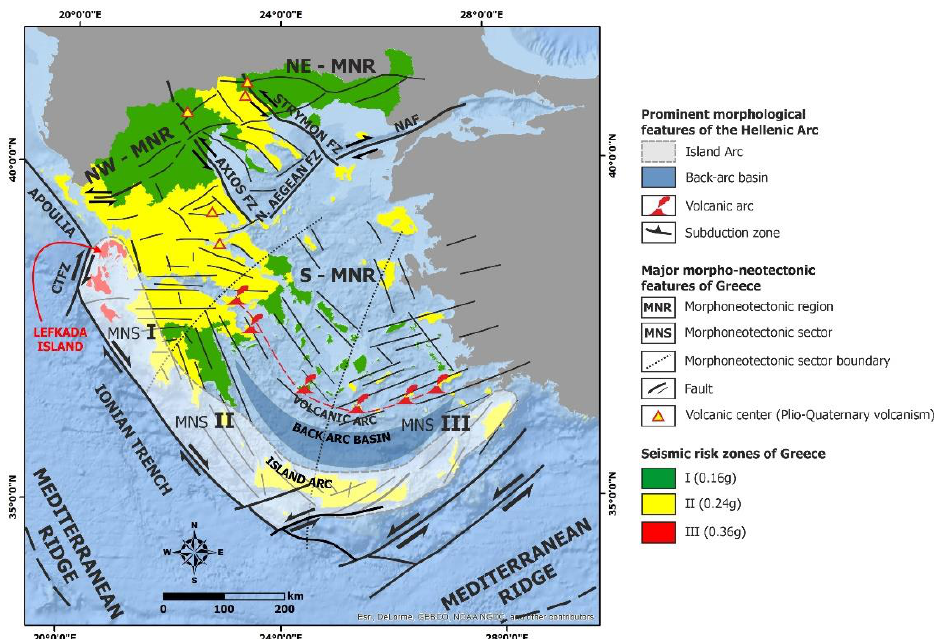
Figure 1. Map of the Hellenic Arc showing the location of Lefkada Island at the northwesternmost part of the Hellenic Arc along with the prominent morphological features of the Hellenic Arc and the major morphoneotectonic features based on Mariolakos and Papanikolaou [70,71] and the seismic risk zones of Greece. Lefkada belongs to zone III of the current Greek Building Code with a Peak Ground Acceleration (PGA) value of 0.36 g for a return period of 475 years.